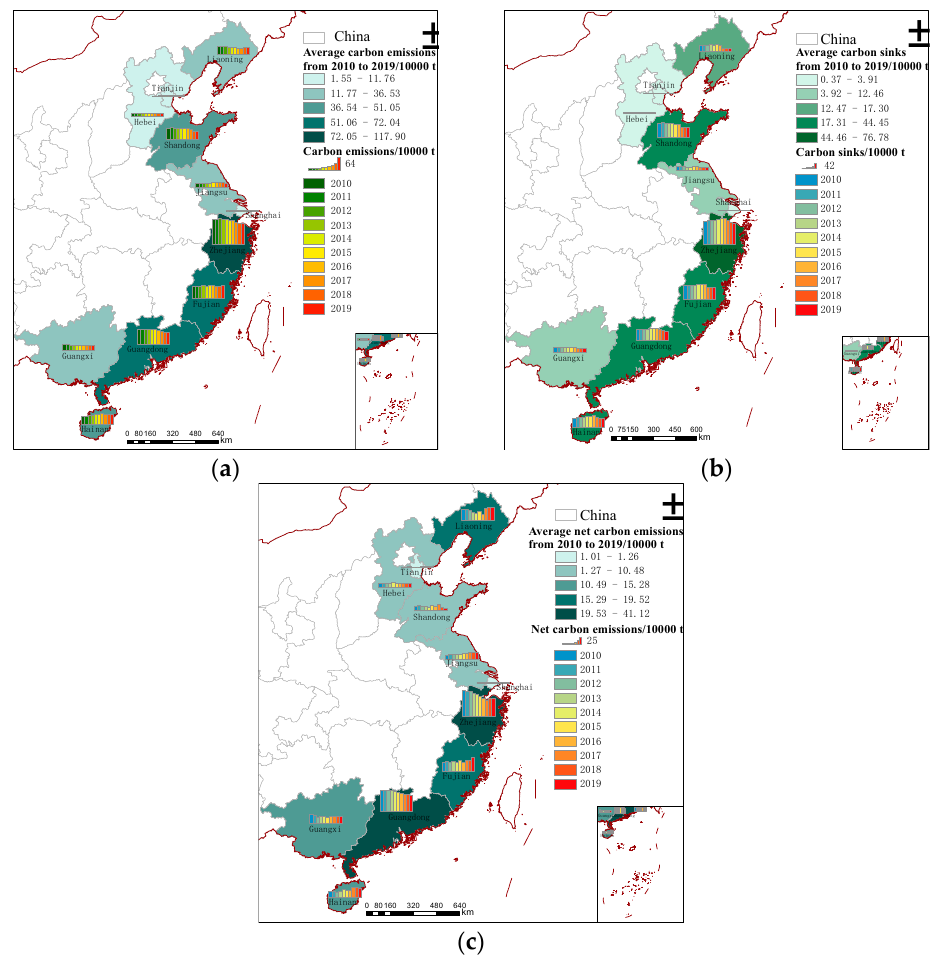
Figure 2. Temporal and spatial distribution of carbon in offshore fishing in China’s coastal provinces from 2010 to 2019. ( a ) Carbon emissions of offshore fishing; ( b ) Carbon sinks of offshore fishing; ( c ) Net carbon emissions of offshore